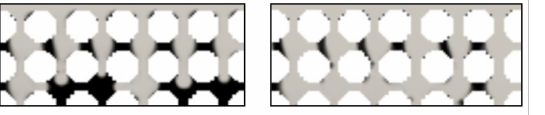
Figure 11. The flow of trapped oil in the VAPEX process as a function of time. Left and right at 6000 s and 15,000 s, respectively. The black and grey colors show oil and solvent phases, respectively, and the white shapes are